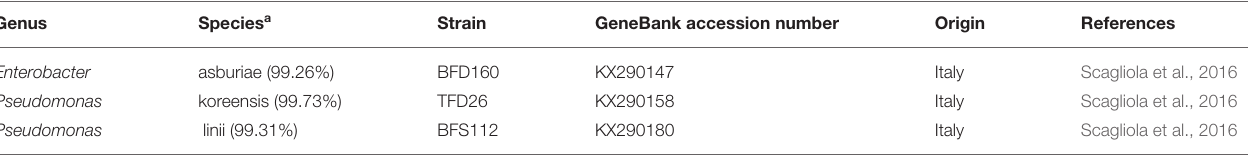
TABLE 1 | Identification of bacterial strains used in the inoculation experiments on the base of 16S rDNA